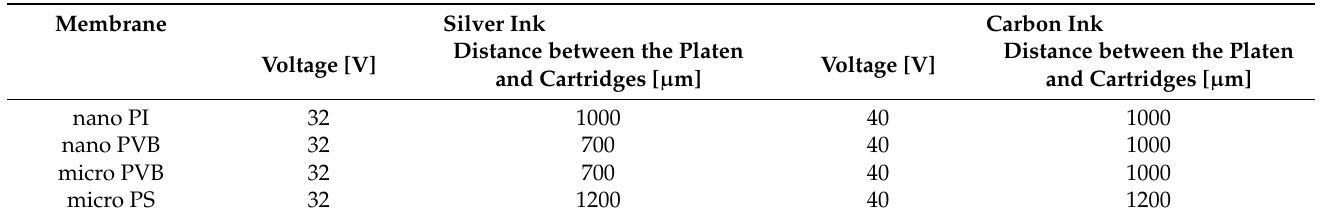
Table 2. Summary of the printing parameters for silver and carbon ink on the PI and PVB nanofibers, PVB and PS